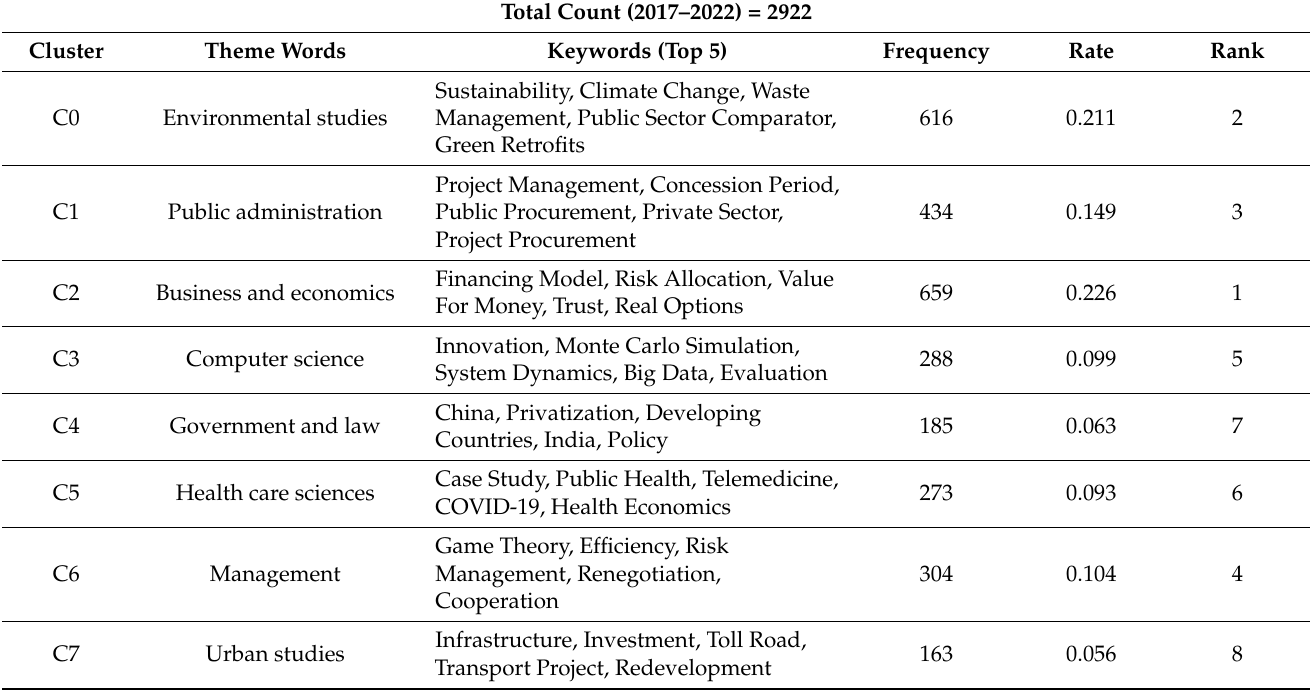
Table 2. Thematic Clustering